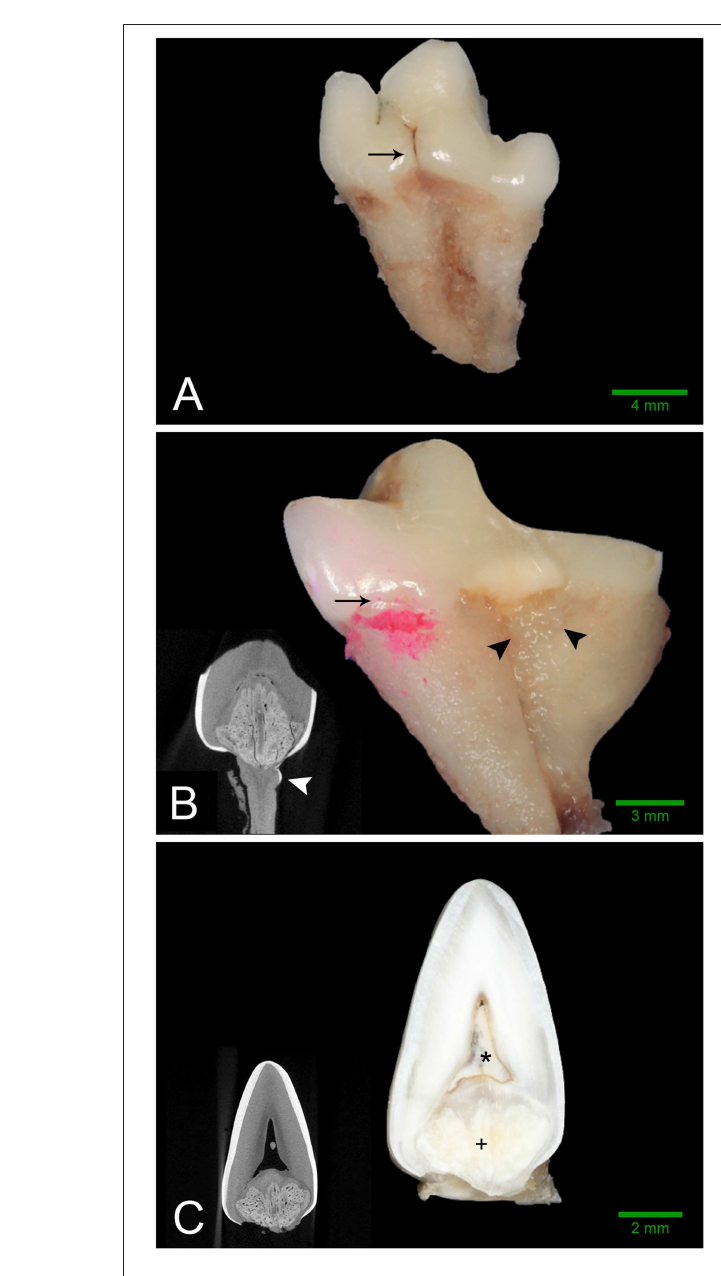
FIGURE 2 | Gross features of affected teeth. Scale bars are for gross images only. (A) Buccal aspect of the left mandibular first molar tooth from dog 3 demonstrating an obvious enamel fissure on the buccal aspect of the tooth (black arrow), as well as severely convergent roots. (B) Mesio-lingual aspect of the right mandibular first molar tooth from dog 2. Disclosing solution has been used to highlight a subtle enamel fissure on the mesiolingual aspect of the tooth (black arrow). Irregular, thin, ectopic enamel extends down the radicular surface in the region of the furcation (black arrowheads). Severely convergent roots and abrasion with tertiary dentin are also evident. ( B , inset) Transverse micro-CT reconstruction at the level of the furcation confirming the presence of hyperattenuating material on the root surface consistent with ectopic enamel (white arrowhead). (C) Bucco-lingual section through the left mandibular first molar tooth of Dog 1. A solid mass of abnormal hard tissue ( + ) is located on the floor of the pulp chamber. The pulp chamber is denoted with an (*). ( C , inset) Transverse micro-CT reconstruction along the same plane as the